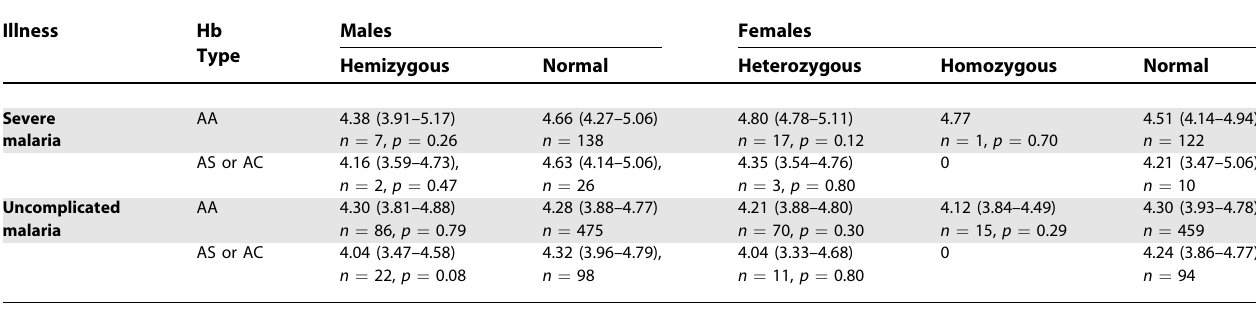
Table 3. Parasite Densities in Cases of Severe or Uncomplicated Malaria in Children (cid:4) 5 y According to Hb Type, Sex, and G6PD